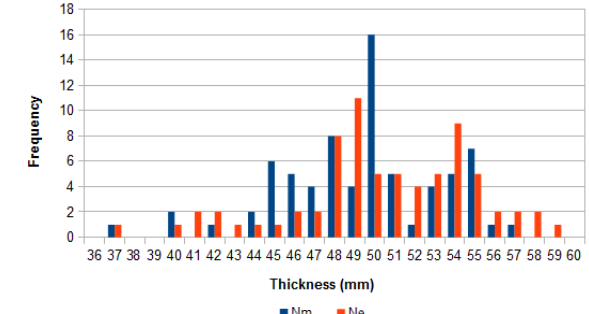
Figure 4. Graph regarding the distribution curve trend of bricks thickness in case A. Nm: direct measurements on site;